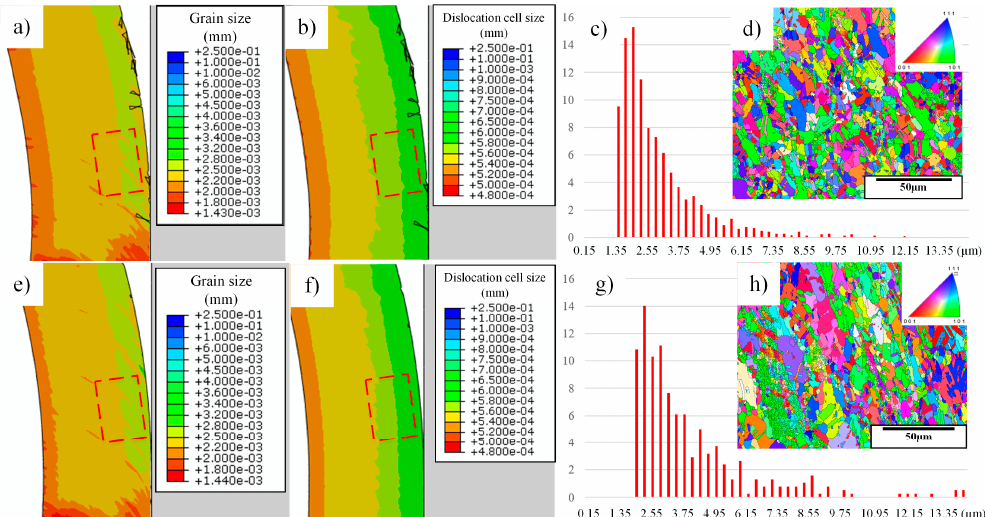
Figure 6. Simulation and experimental results of microstructure information inside the chip area ( a )–( d ) are the results for 750 m/min and ( e )–( h ) are the results for 1500 m/min. ( a ) and ( e ) are the simulation results of the grain size. ( b ) and (f ) are the predicted dislocation cell sizes. ( c ) and ( g ) are the experimental data of the actual grain size distribution inside the red frame of ( a ) and ( e ), respectively. ( d ) and ( h ) are the experimental data of the microstructure mapping in the selected area in ( a ) and ( b ), respectively.